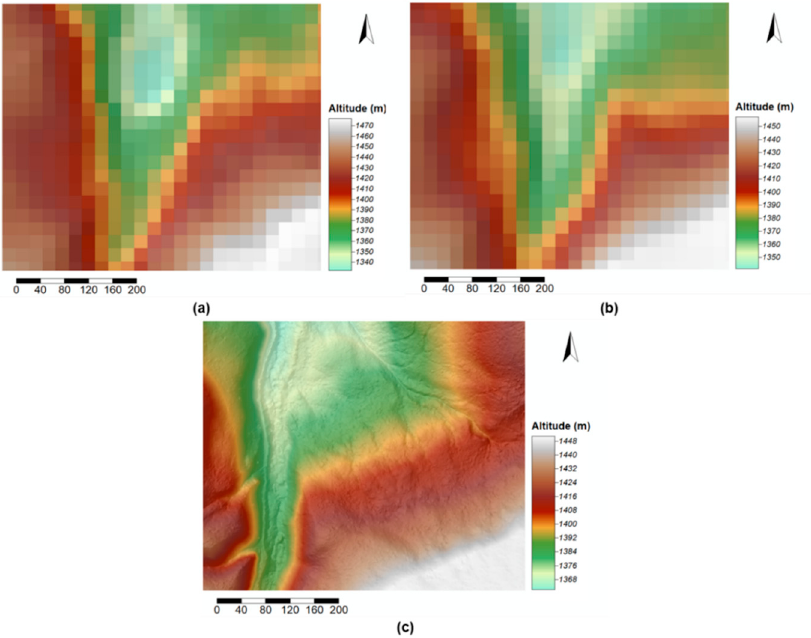
Figure A1. DTMs for a subset of the test site, generated from: ( a ) ASTER data, at the original 21.0 m resolution, ( b ) SRTM data, at the original 21.0 m resolution and ( c ) ALS data, interpolated at 0.5 m resolution using the Natural Neighbour algorithm. Table A1. Statistics for vertical displacement between DTM NN and DTM ASTER / DTM SRTM . Mean Signed Models Compared Displ.